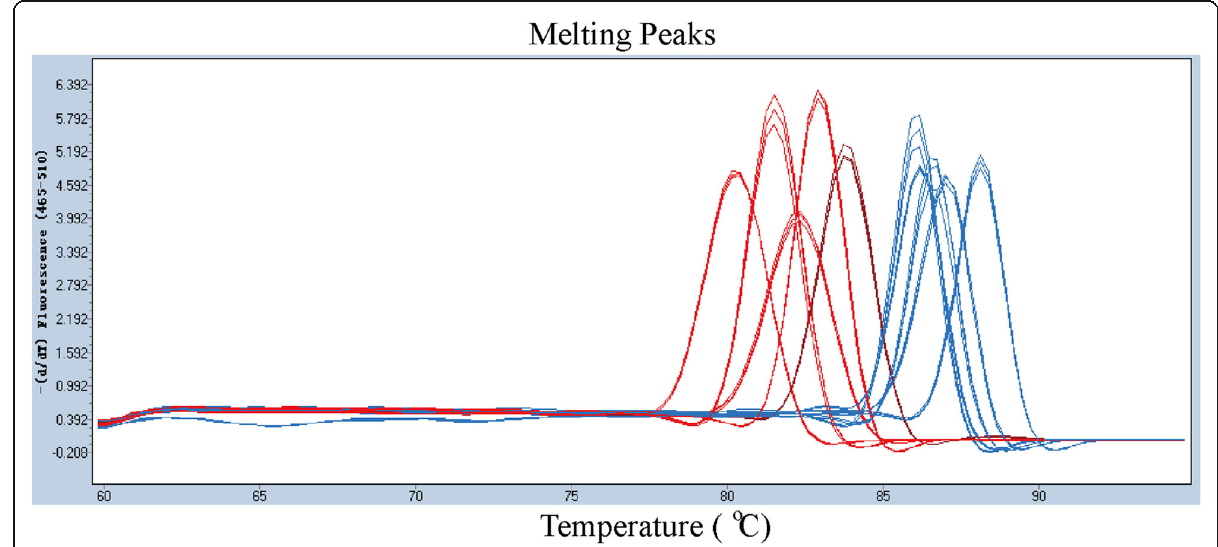
Fig. 2 Melt curves for the 10 candidate reference genes with single peak obtained from three